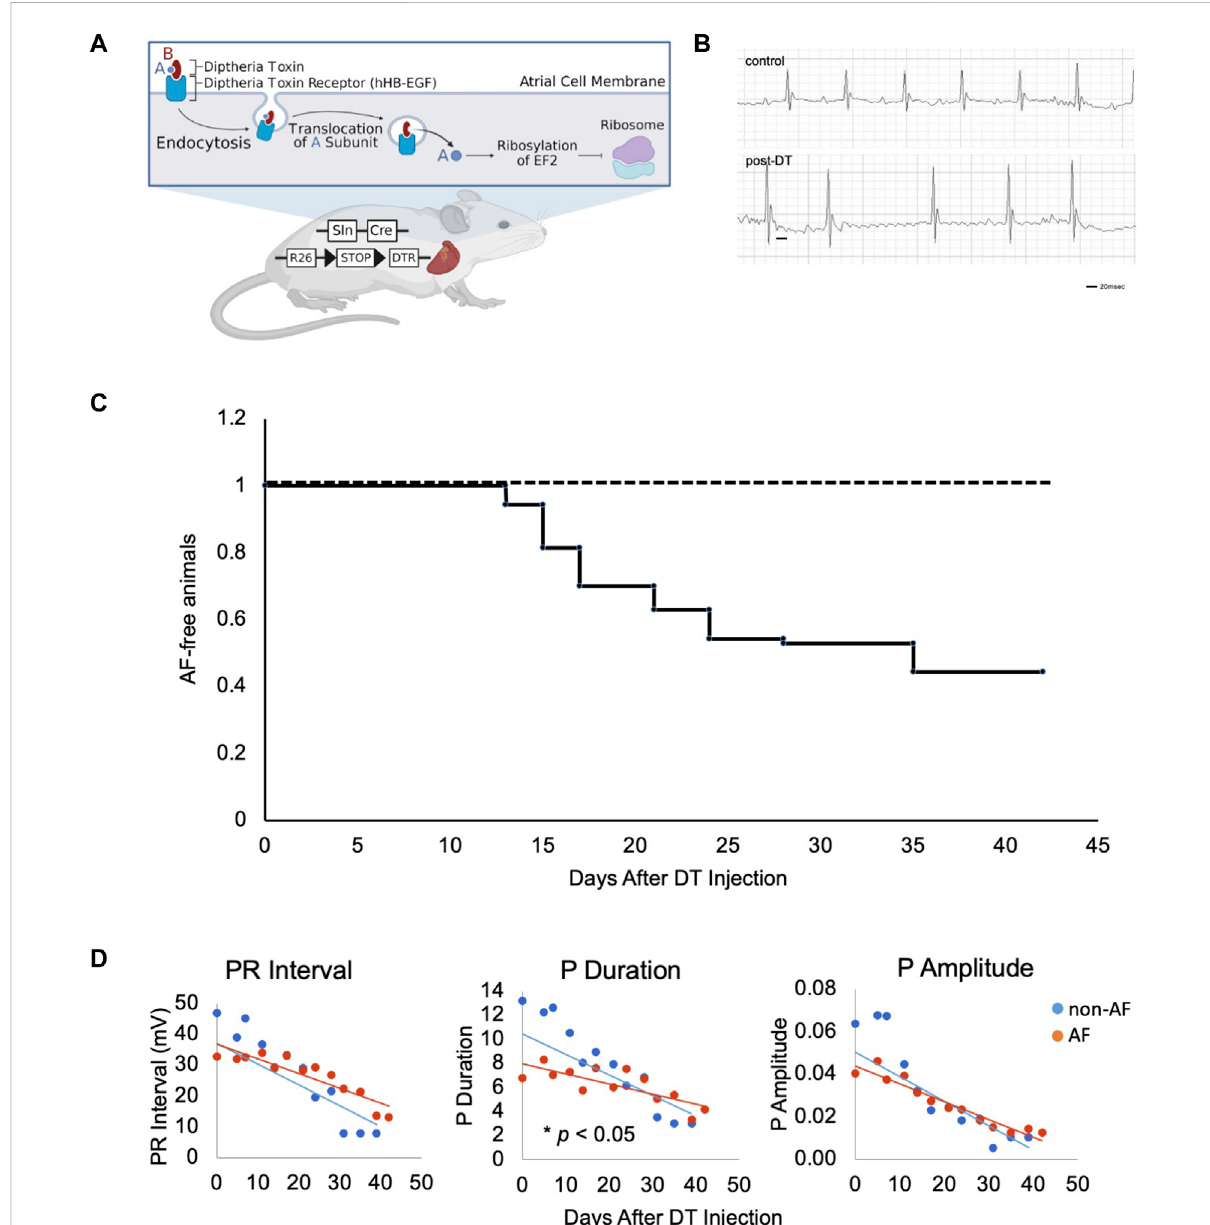
FIGURE 1 Design of murine model of atrial fi brillation (A) . Illustration of the generation of mouse model and experimental scheme of DT treatment. DT consists of subunits A (blue) and B (red) linked by disul fi de bridges. DT binds to hHB-EGF speci fi cally expressed on the cell surface of atrial myocytes of Sln+/Cre; R26+/DTR mice. Upon endocytosis of receptor-ligand complex, A subunit translocates into the cytosol, ribosylates host EF2, and inactivates proteinsynthesis, resultinginmild damage inatrialmuscle. Figure drawn usingBioRender software. (B) . Representative ECGsof two control mice atDay 18 and 21 and three AF mice at Day 17, 21 and 21 post-DT, respectively. (C) . Kaplan-Meyer curve ofanimals freefrom AF after DT injection. DT was injected at Day 0 and 14. ( n =